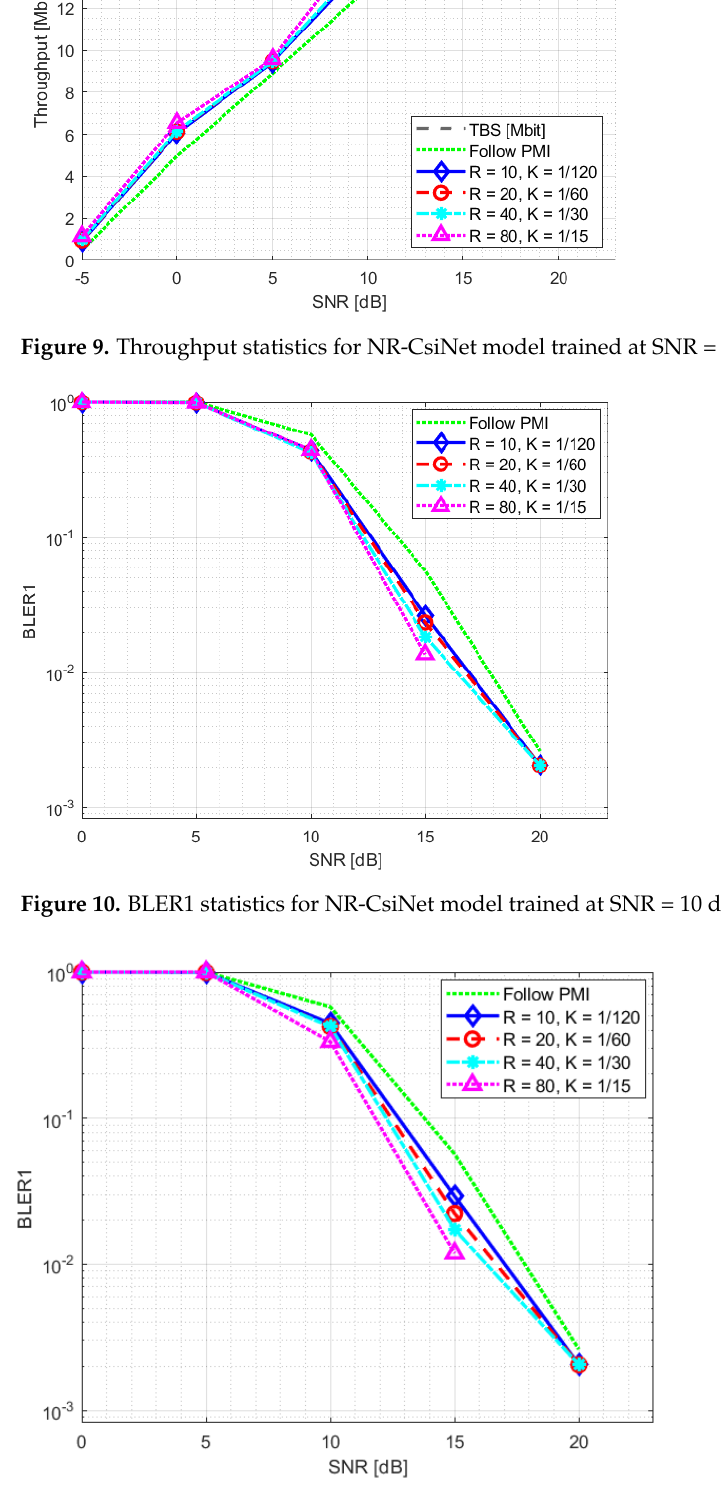
Figure 11. BLER1 statistics for NR-CsiNet model trained at SNR = 20 dB